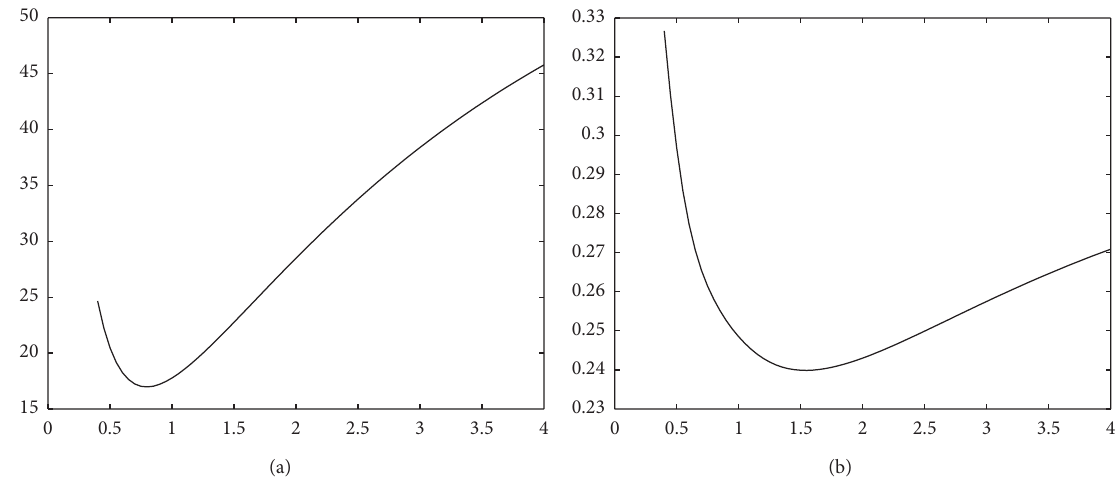
̃𝑓‖ 2 2 (a) and the gradient penalty values